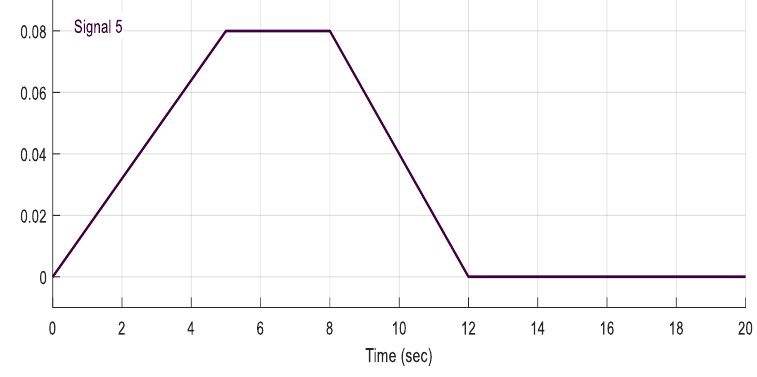
Figure 16. Change in demand in test 2. Inventions 2020 , 5 , 53